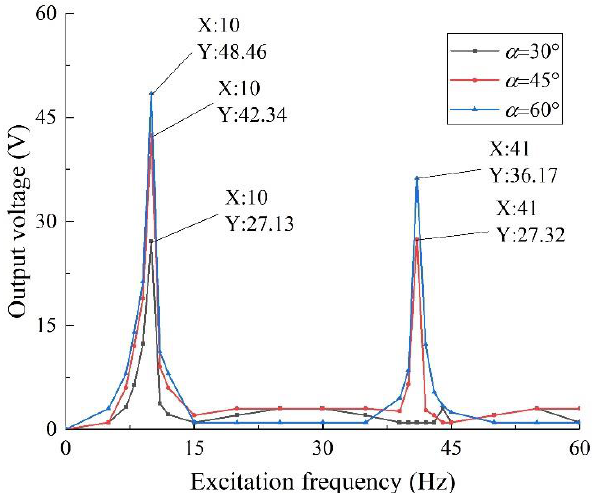
Figure 11. Multi-dimensional harvesting output voltage.